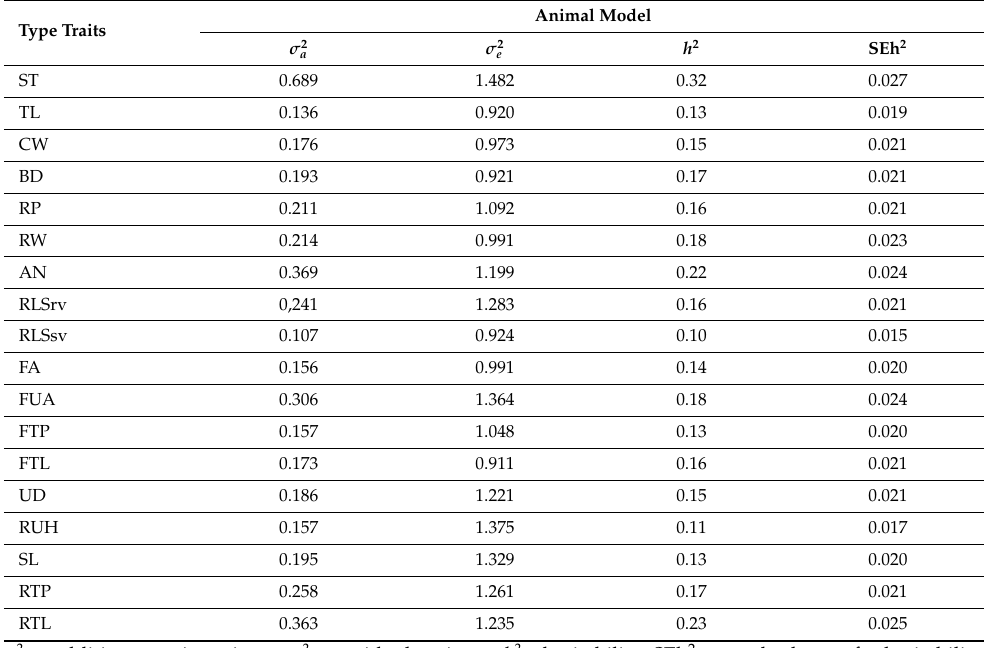
Table 4. Estimates for the additive genetic variance ( σ 2 a ), heritability ( h 2 ), and standard error (SEh 2 ) for type